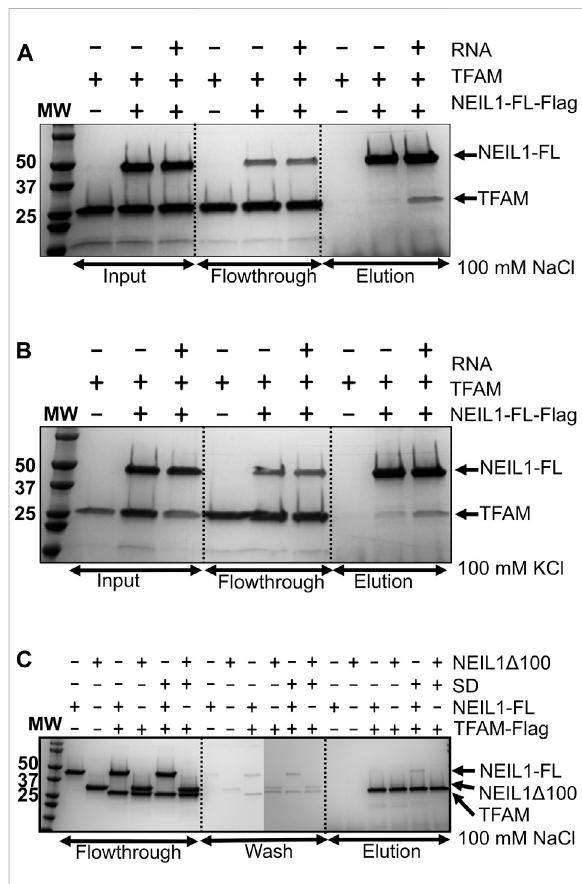
FIGURE 2 Af fi nity pull-down experiments display an interaction between NEIL1 and TFAM using recombinantly puri fi ed proteins. (A) Flag tagged NEIL1 was used to pull down TFAM in the presence ofRNAinabuffercontaining100 mMNaCl.TFAMisobserved in the elution fractions in the absence and presence of RNA. (B) Flag tagged NEIL1 was used to pull down TFAM in the presence of RNA in a buffer containing 100 mM KCl. Under these conditions, TFAM is also observed in the elution fractions in the absence and presence of RNA. (C) The reverse pull-down experiment using Flag-tagged TFAM was performed. Full-length NEIL1 (NEIL1-FL) and a truncated NEIL1 enzyme lacking 100 residues from disordered C-terminal region (NEIL1- Δ 100) were observed in the elution fractions in the presence and absence of DNA. Non- speci fi c binding of untagged TFAM, NEIL1-FL, and NEIL1- Δ 100 with Flag beads was not detected as shown in elution fractions when the interaction partner is absent.